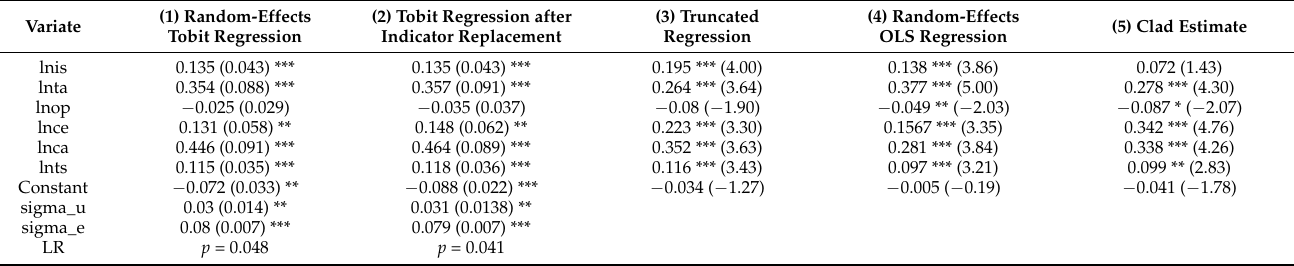
Table 5. The regression